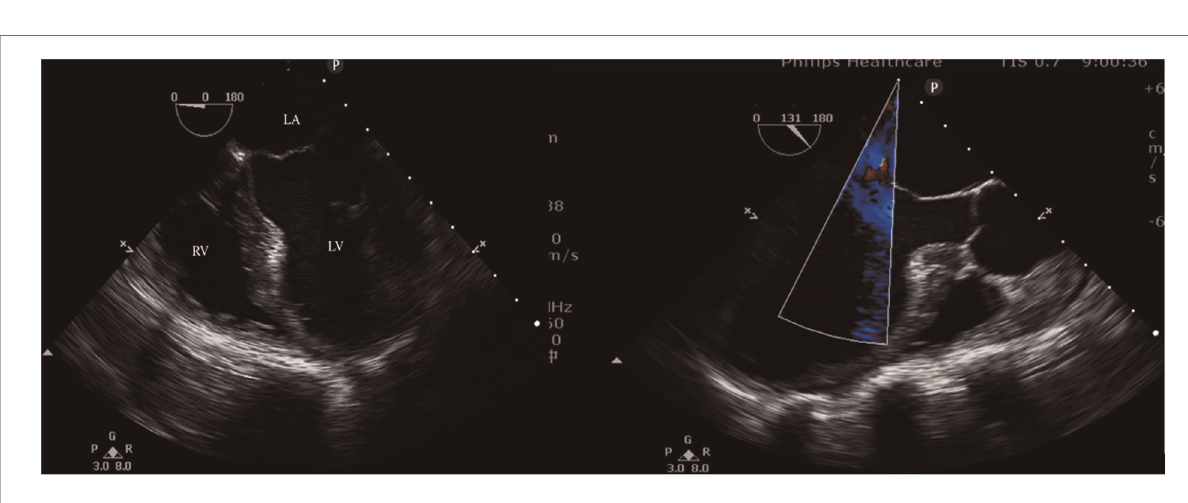
FIGURE 3 Intraoperative transesophageal